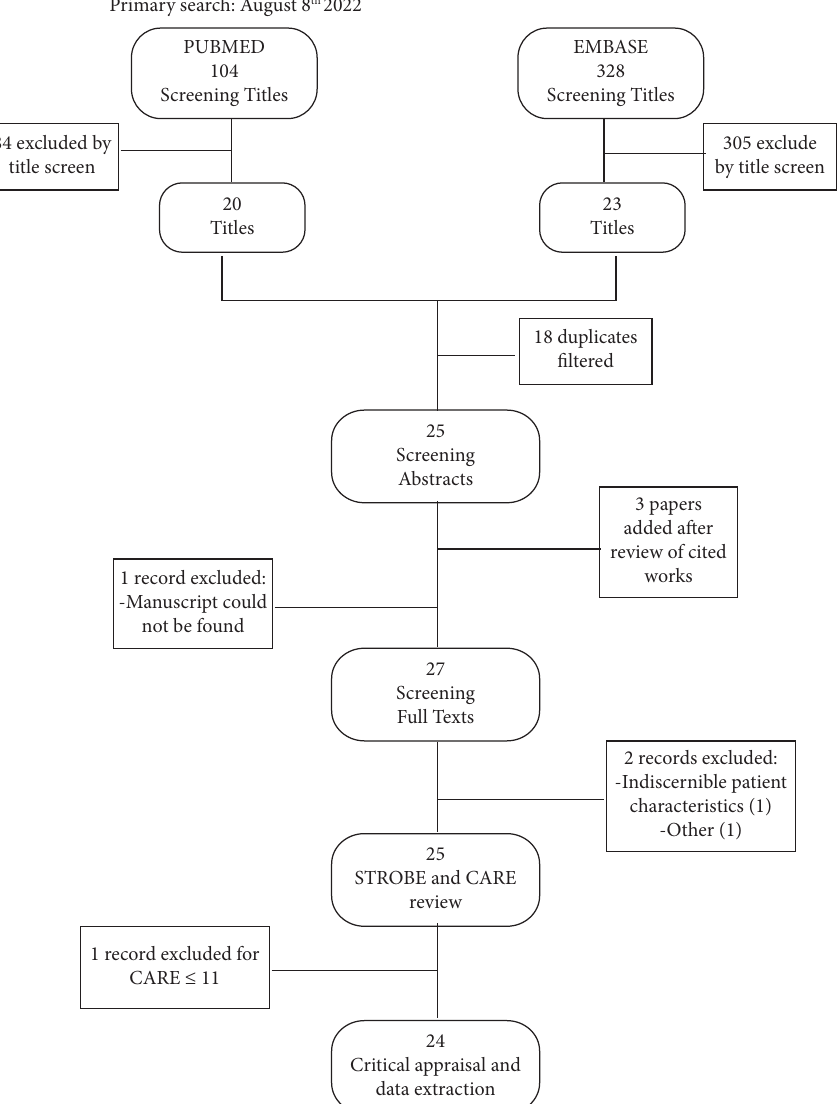
Figure 1: Flowchart for our literature search and selection of relevant